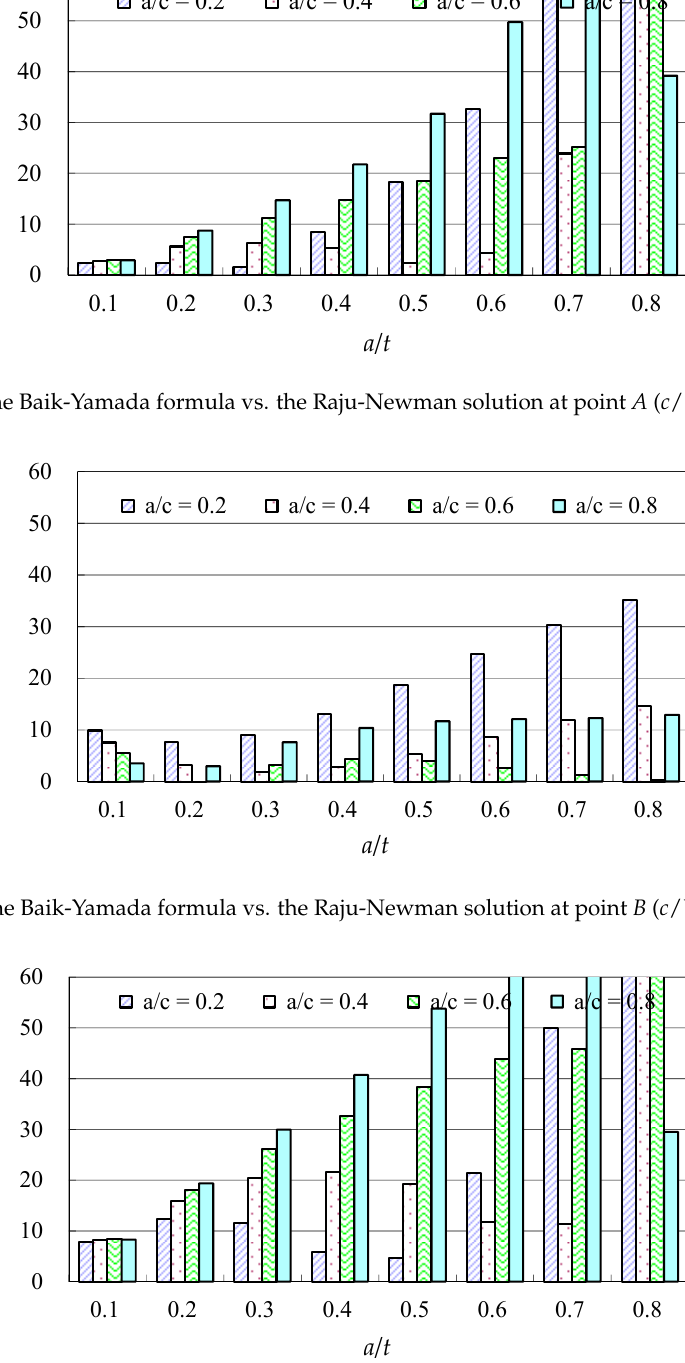
Figure 5. The Baik-Yamada formula vs. the Raju-Newman solution at point A ( c / W = 0.2).